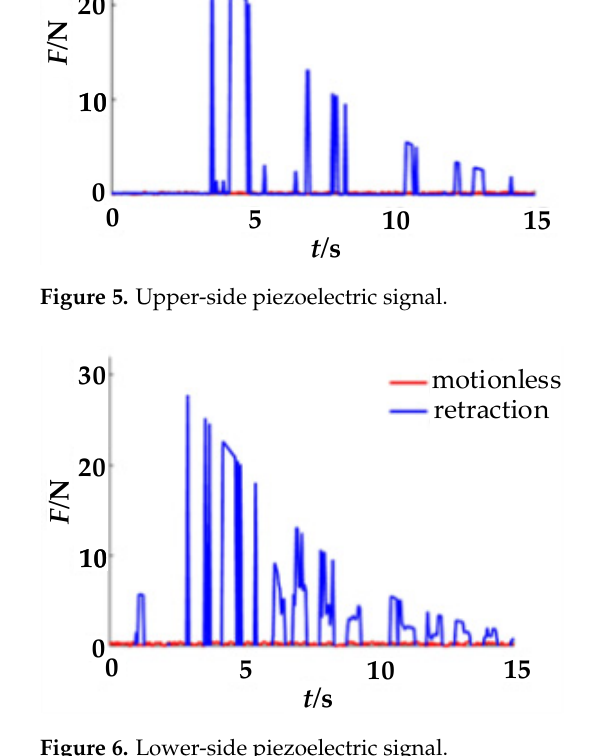
Figure 6. Lower-side piezoelectric signal. gradually decrease with